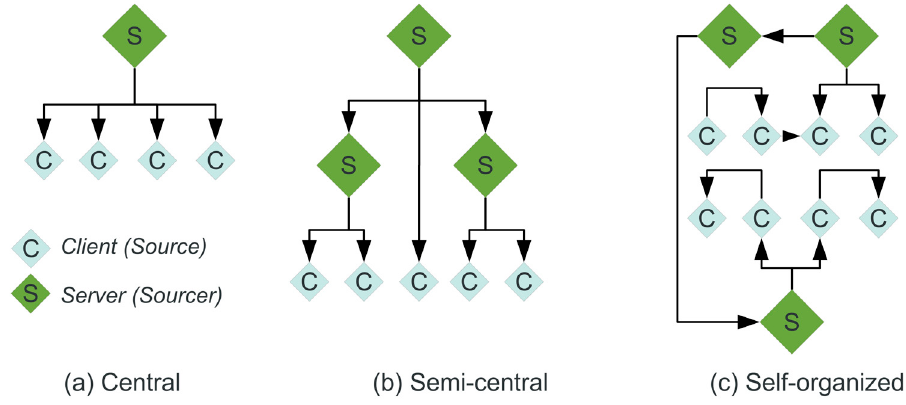
Figure 5. Di ff erent crowd sensing architectures and strategies with data sourcer and data Figure 5. Different crowd sensing architectures and strategies with data sourcer and data sources .